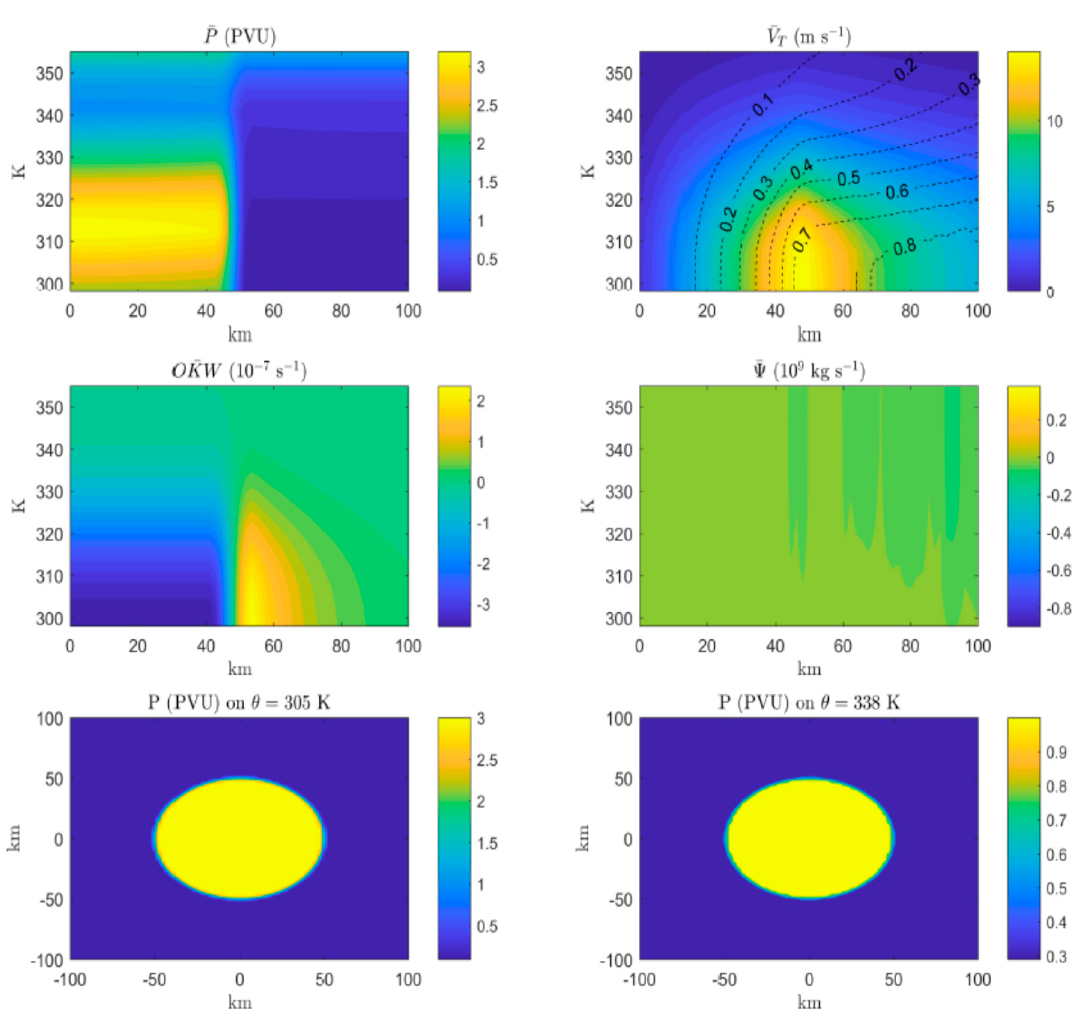
Figure 2. The initial condition for the tropical storm-like vortex. The upper left panel shows the azimuthal mean PV (in PVU where 1 (cid:1842)(cid:1848)(cid:1847) = 10 (cid:2879)(cid:2874) m (cid:2879)(cid:2870) K kg (cid:2879)(cid:2869) s (cid:2879)(cid:2869) ). The upper right panel shows the azimuthal mean azimuthal velocity with isosurfaces of absolute angular momentum (in units of 10 (cid:2874) m (cid:2870) s (cid:2879)(cid:2869) ). The middle left panel shows the azimuthal mean Obuko-Weiss parameter. The middle right panel shows the azimuthal mean isentropic mass streamfunction (in units of 10 (cid:2877) kg/s ). The lower left panel shows the PV on the 305 K surface. The lower right panel shows the PV on the 338 K